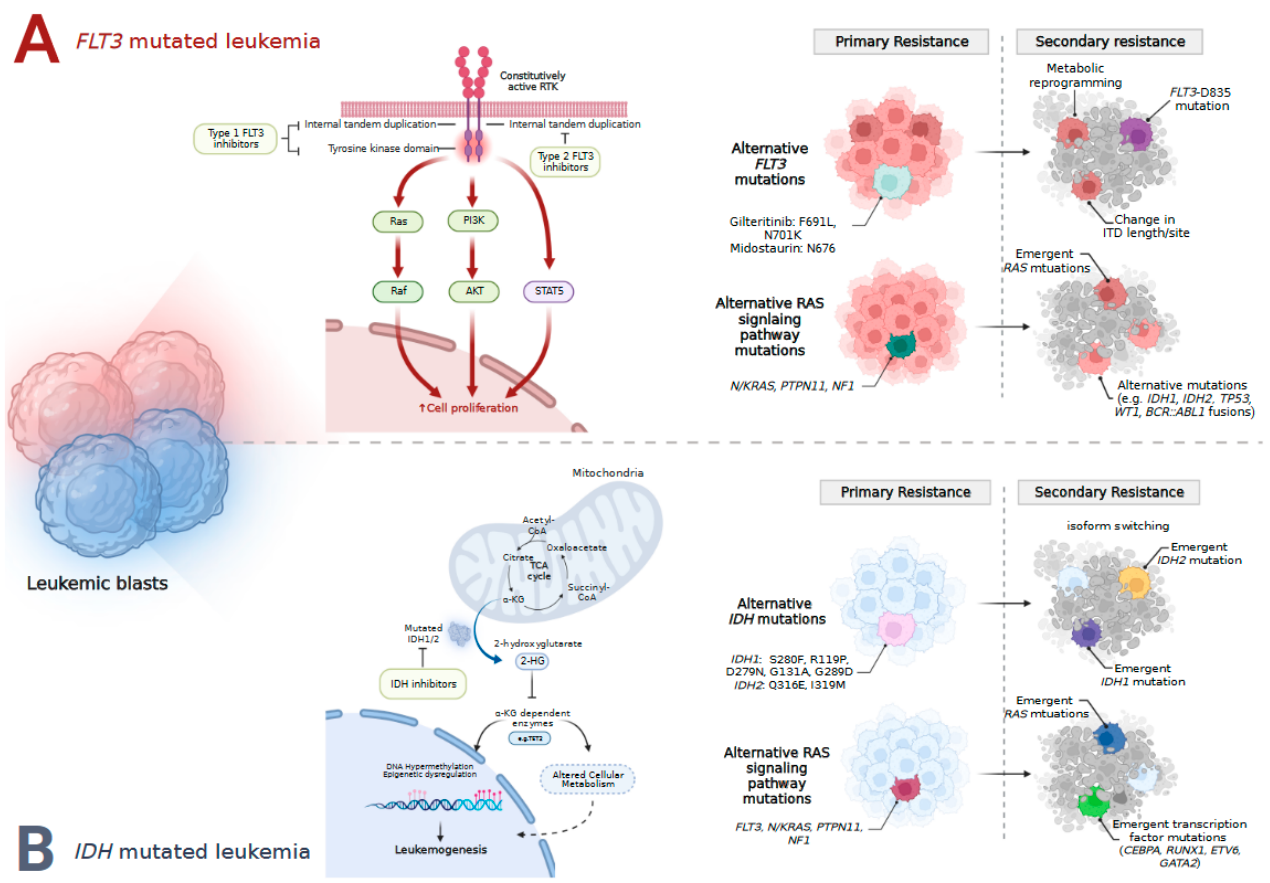
Figure 2. Mechanisms of leukemogenesis in FLT3 -ITD/TKD-mutated acute myeloid leukemia. Constitutive activation of the FLT3 receptor results in downstream signaling pathway activation promoting cell proliferation and survival. Resistance to FLT3 inhibitor therapy can occur via both primary and secondary resistance mechanisms ( A ). Mechanisms of leukemogenesis in IDH -mutated acute myeloid leukemia. Production of the oncometabolite 2-hydroxyglutarate results in epigenetic reprogramming and altered cellular metabolism. As with resistance to FLT3 inhibitors, both primary and secondary resistance mechanisms have been described to IDH inhibitors ( B ).